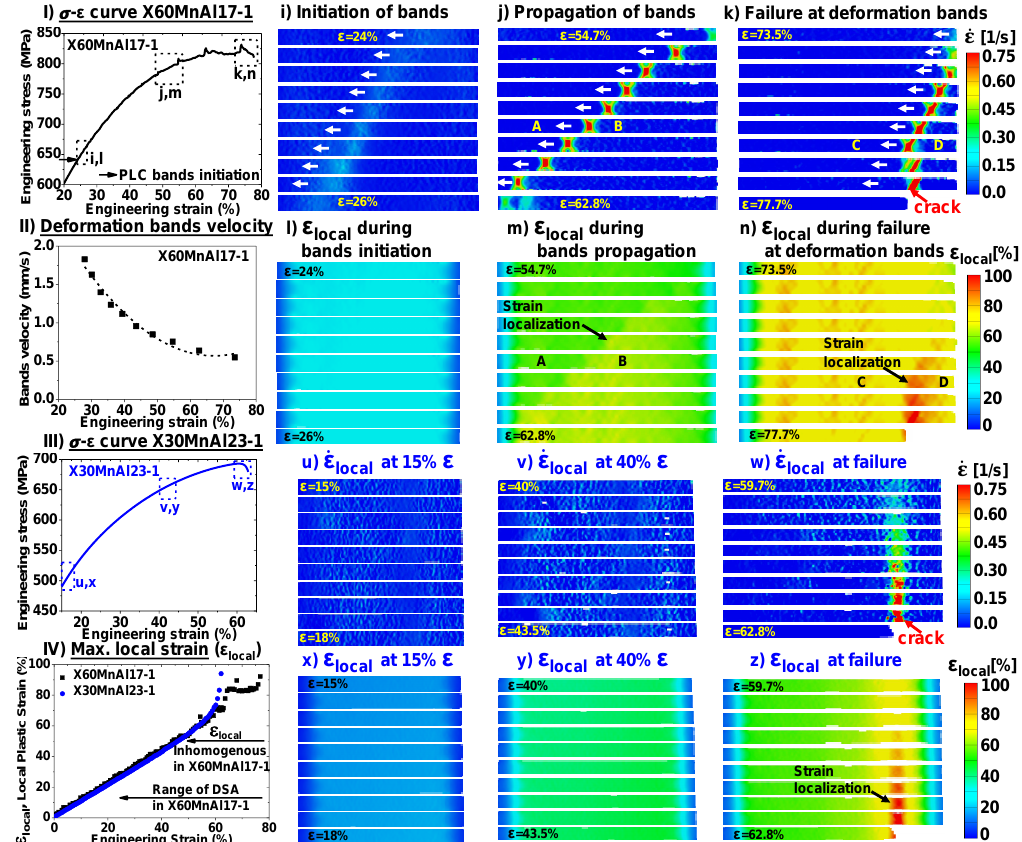
Figure 7. Deformation bands initiation, propagation and their location at the point of failure obtained from the tensile tests in conjunction with DIC: ( I ) X60MnAl17-1: enlarged view of σ – ε curve depicting the initiation of deformation bands ( i , l ), propagation of deformation bands ( j , m ) and failure at deformation bands ( k , n ), ( II ) plot of the deformation bands velocity versus strain, ( III ) X30MnAl23-1: enlarged view of σ – ε curve depicting no deformation bands initiation and propagation ( u , v , x , y ) and failure due to diffuse necking and strain localization ( w , z ), ( IV ) plot of the maximum local plastic strain versus strain; ( i – k , u – w ) shows local strain rate (˙ ε local ) distribution; ( l – n , x – z ) shows local strain ( ε local ) distribution; the legend for ˙ ε local and ε local distribution ( right ); white arrows indicate the direction of propagation of the deformation bands; the macroscopic strain at the start and end of deformation band is given; images were shown in steps of ∼ 0.4–0.6% macroscopic